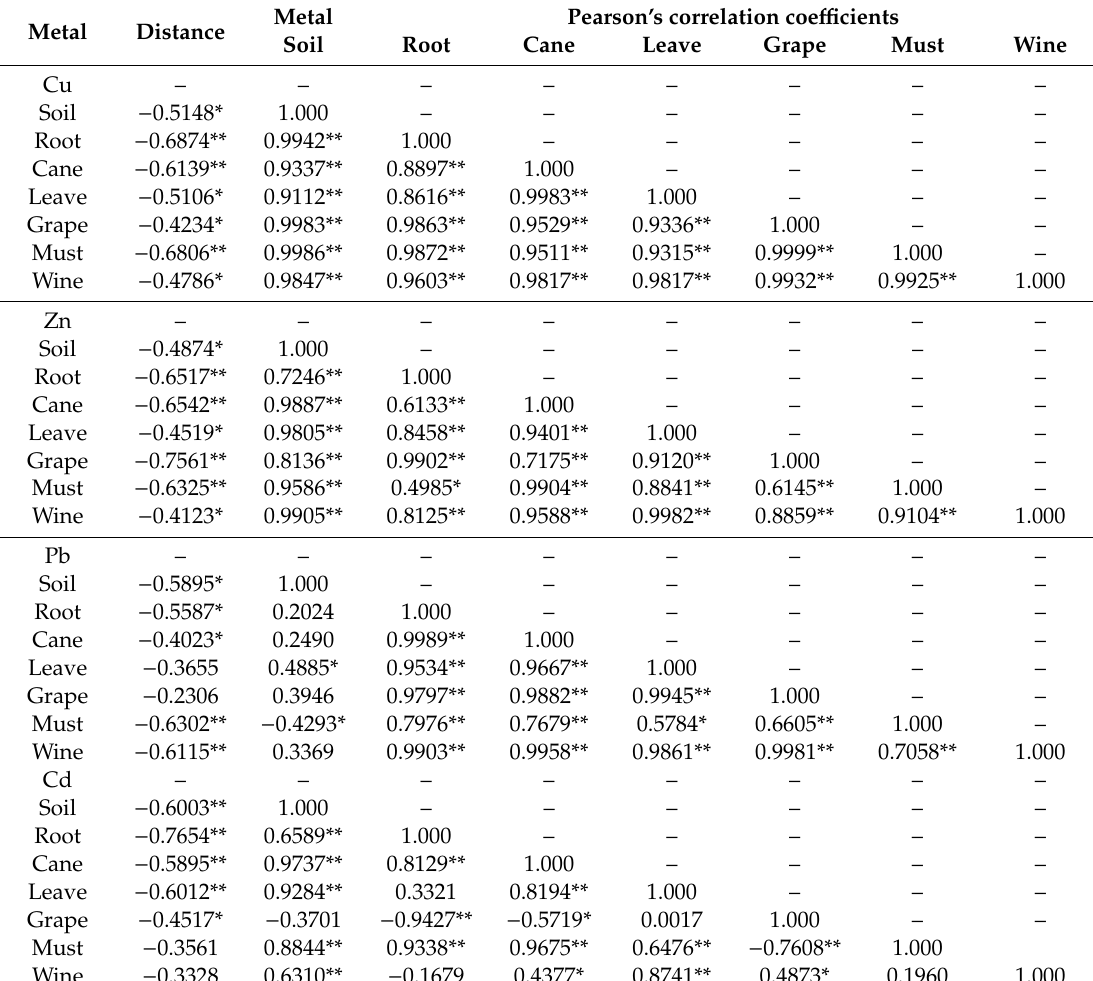
Table 4. Pearson’s correlation between the contents of the investigated element in plants parts and distance, between the contents of elemental in plants parts and related contents in soil, and between content in individual